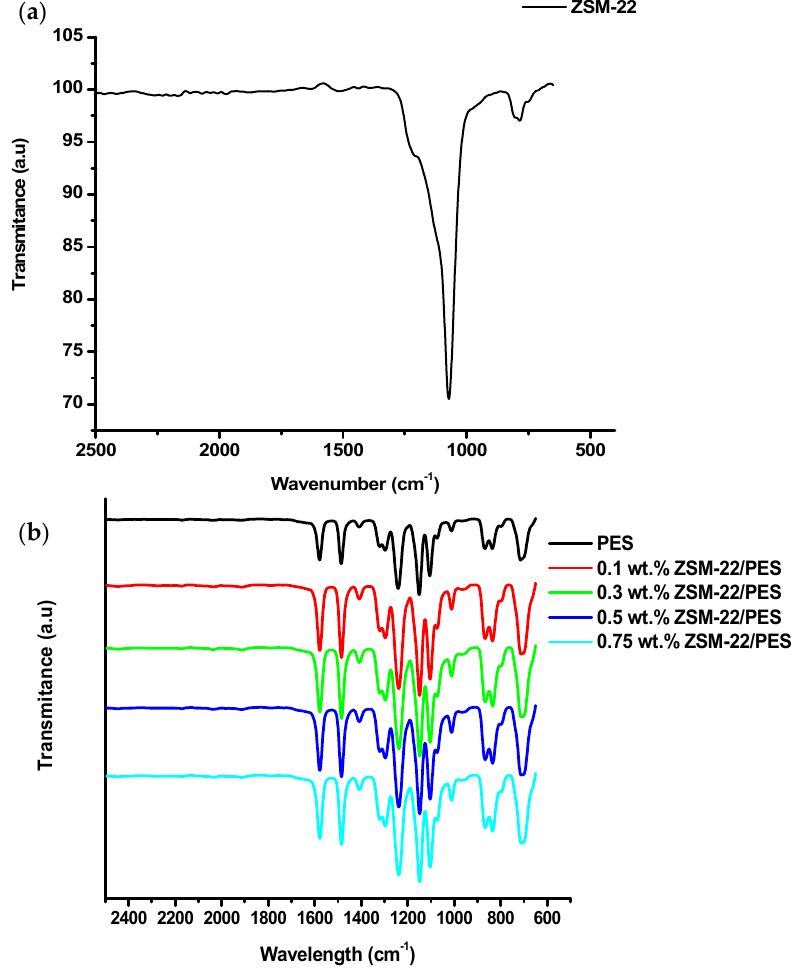
Figure 3. ( a ) FTIR Spectra of ZSM-22 material prepared via hydrothermal synthesis method, ( a , b ) ZSM-22 / PES NF / RO membranes prepared via direct phase inversion method.